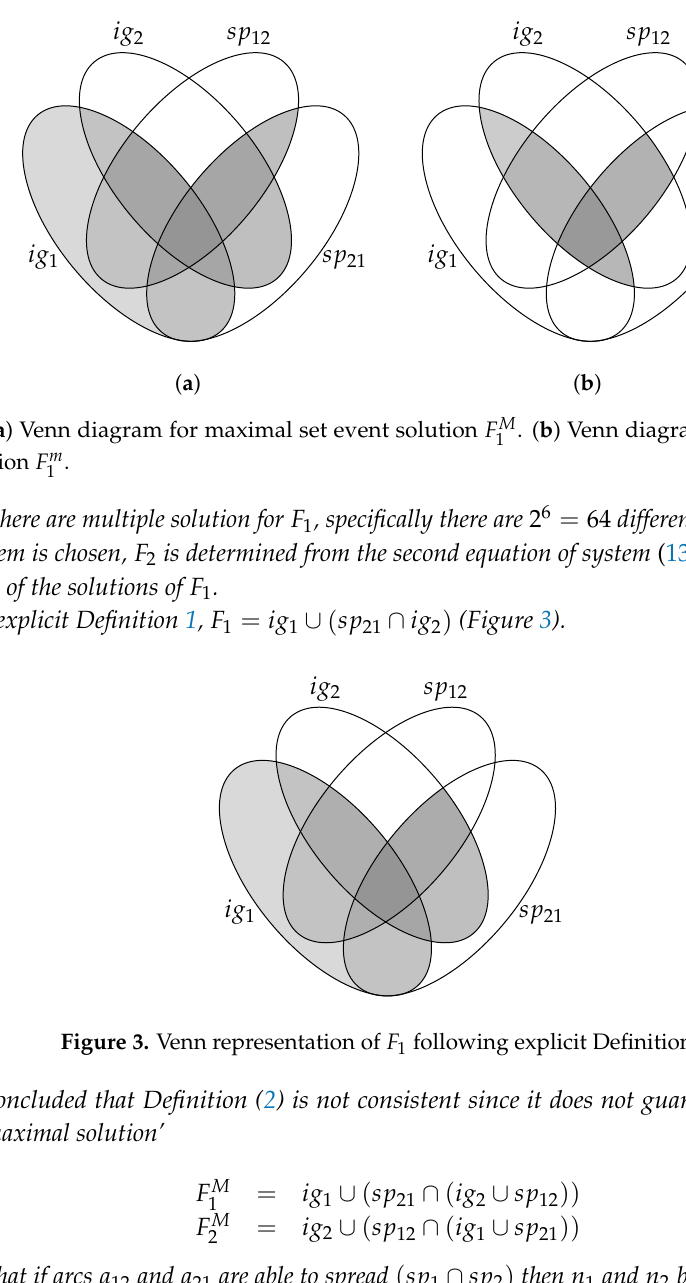
Figure 3. Venn representation of F 1 following explicit Definition